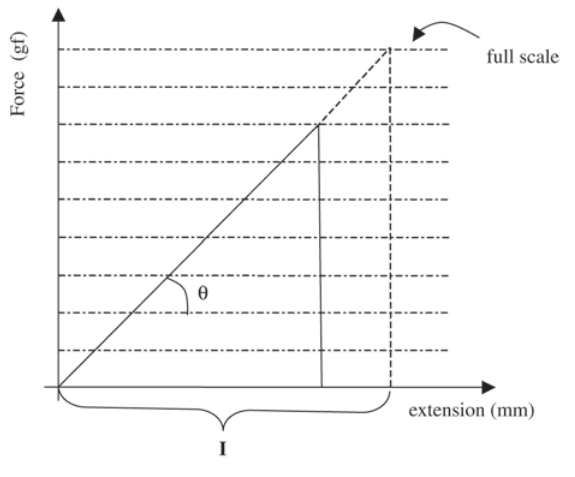
Figure 2. Graphic representation of a tensile test of fibre single